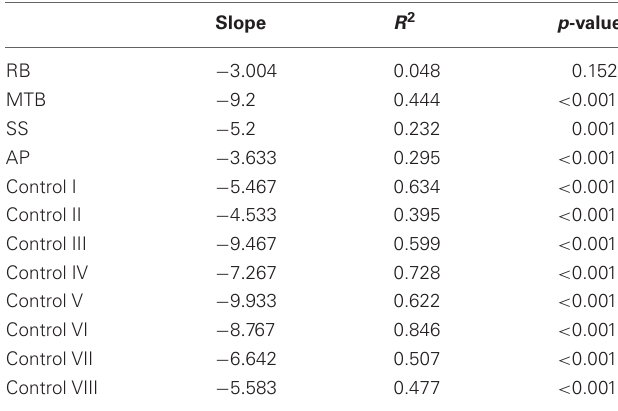
Table 2A | Regression values for Closed-loop grasping.